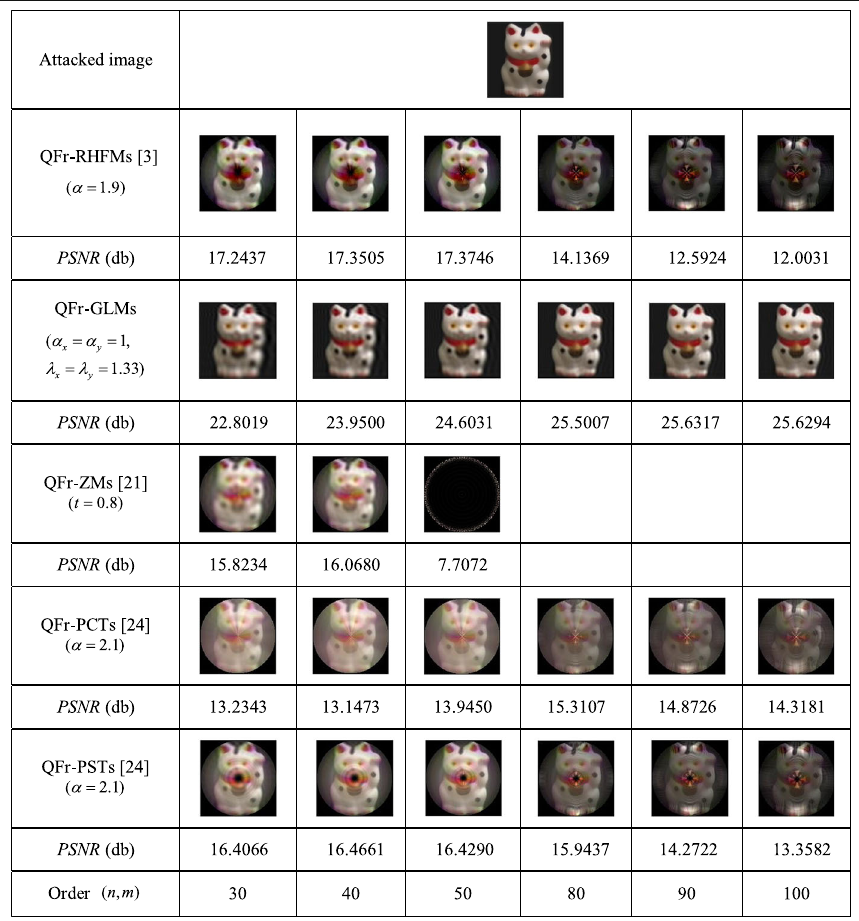
Table 4 Reconstruction performance comparison of different color-image in higher-order moments (under smooth filtering condition, filtering window is 5 ×